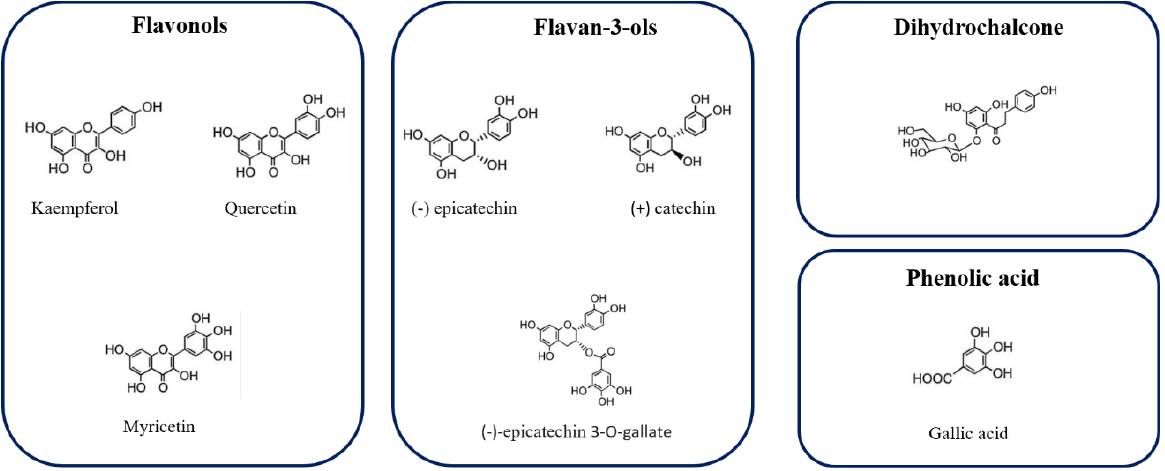
Figure 1. HPLC-PDA chromatograms of hazelnut skin extract: ( A ) aqueous extract (λ = 280); ( B ) methanolic extract (λ = 360). Peak numbers are referred to Table 1 and Table 2.